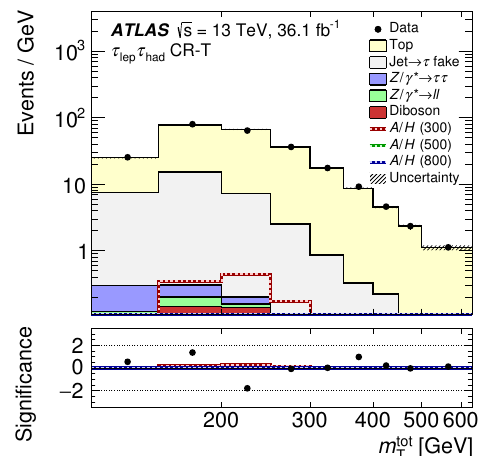
Figure 6. Distribution of m tot in the t (cid:22) t enriched control region (CR-T) of the (cid:28) lep (cid:28) had channel. T Events containing (cid:28) had-vis candidates that originate from jets are removed from all processes other than Jet (cid:28) fake. The binning displayed is that entering into the statistical (cid:12)t discussed in ! section 8, with minor modi(cid:12)cations needed to combine the (cid:28) lep (cid:28) had channels and with